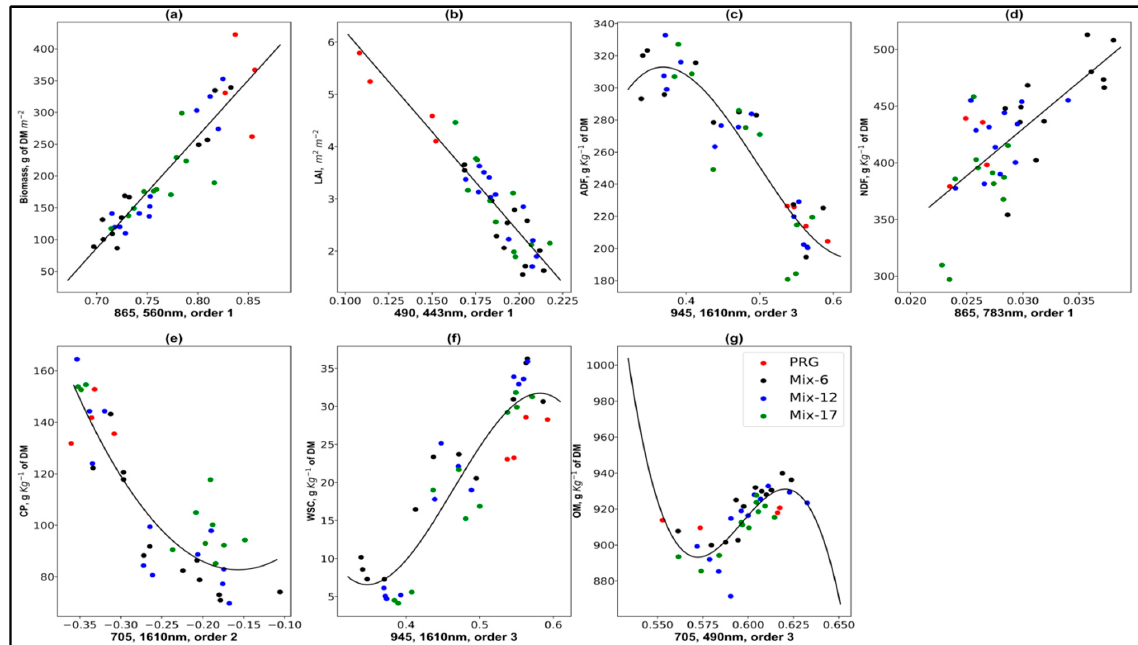
Figure 4. Best modelled relationships between pasture parameters and respective normalised difference indices (NDIs): ( a ) biomass, ( b ) leaf area index (LAI), ( c ) acid detergent fibre (ADF), ( d ) neutral detergent fibre (NDF), ( e ) crude protein (CP), ( f ) water soluble carbohydrate (WSC), ( g ) organic matter (OM). For each of the parameters, 39 samples were used to fit the